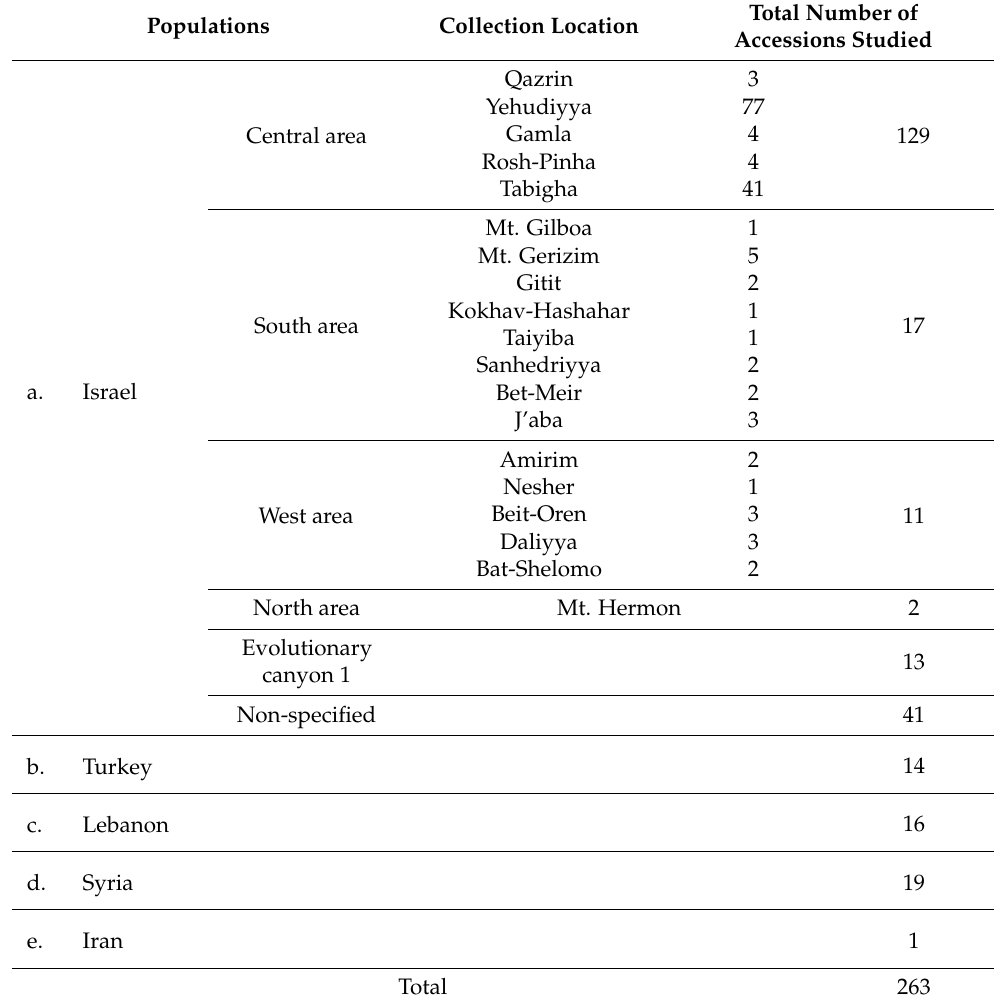
Table 1. List of populations and number of accessions studied from each population along with their collection